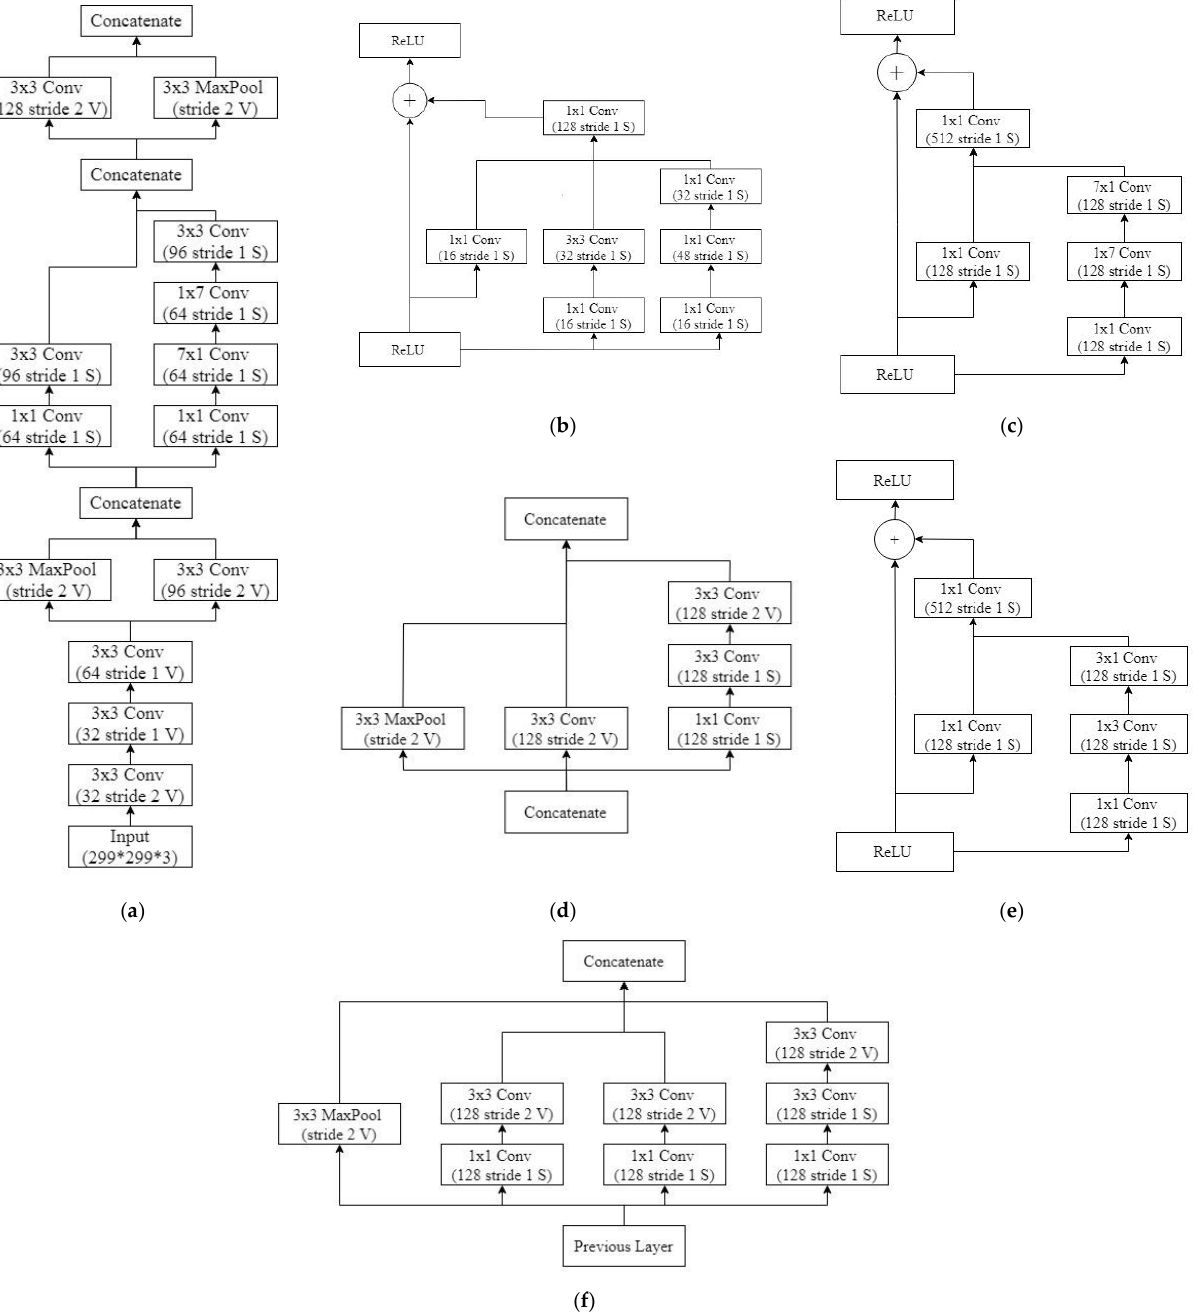
Figure 3. The proposed modular architecture of IR-v2 Type 5: ( a ) Stem; ( b ) Inception-A block; ( c ) Inception-B block; ( d ) 35 × 35 to 17 × 17 reduction module A; ( e ) Inception-C block; and ( f ) 17 × 17 to 8 × 8 reduction module